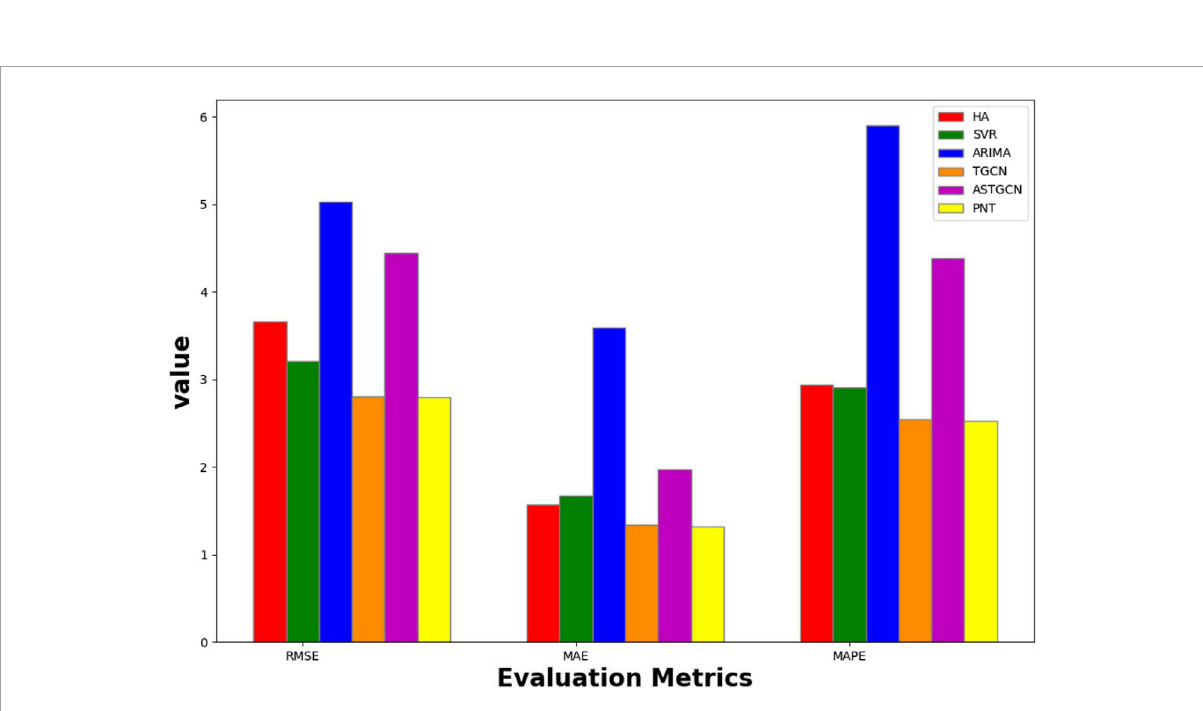
FIGURE 11 pems08-30